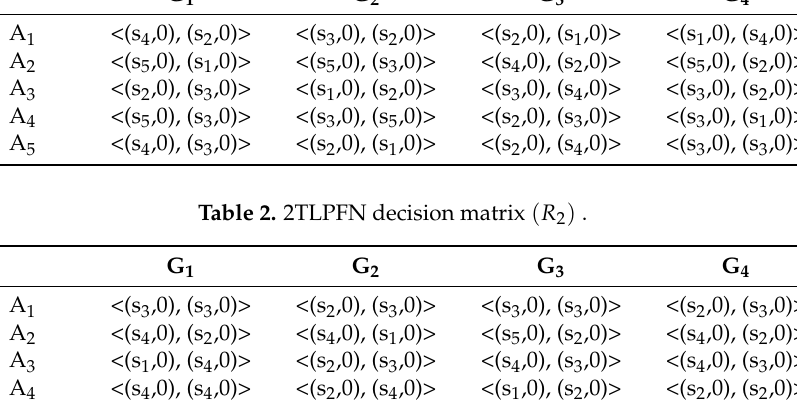
Table 1. 2TLPFN decision matrix ( R 1 ) . G 1